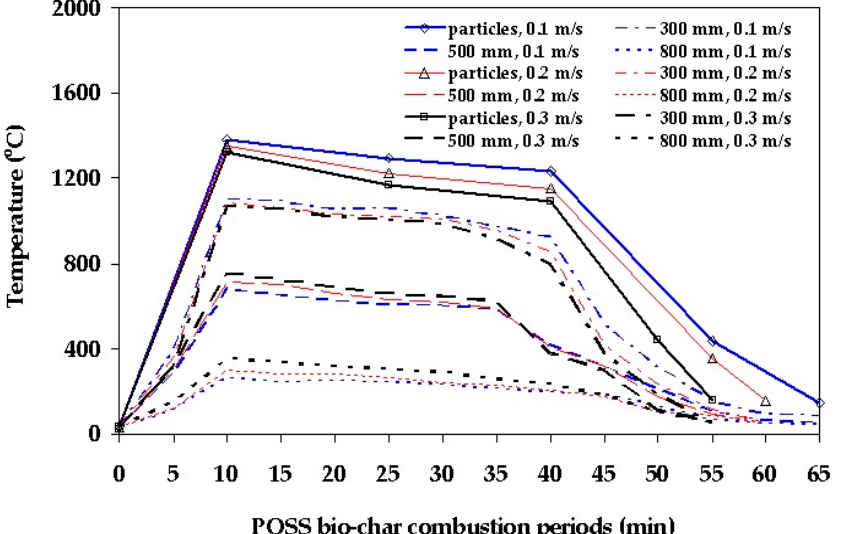
Figure 5. The temperature of 15% d.b. of POSS bio-char moisture content for different clean air speeds and distance locations above the base of the fire.